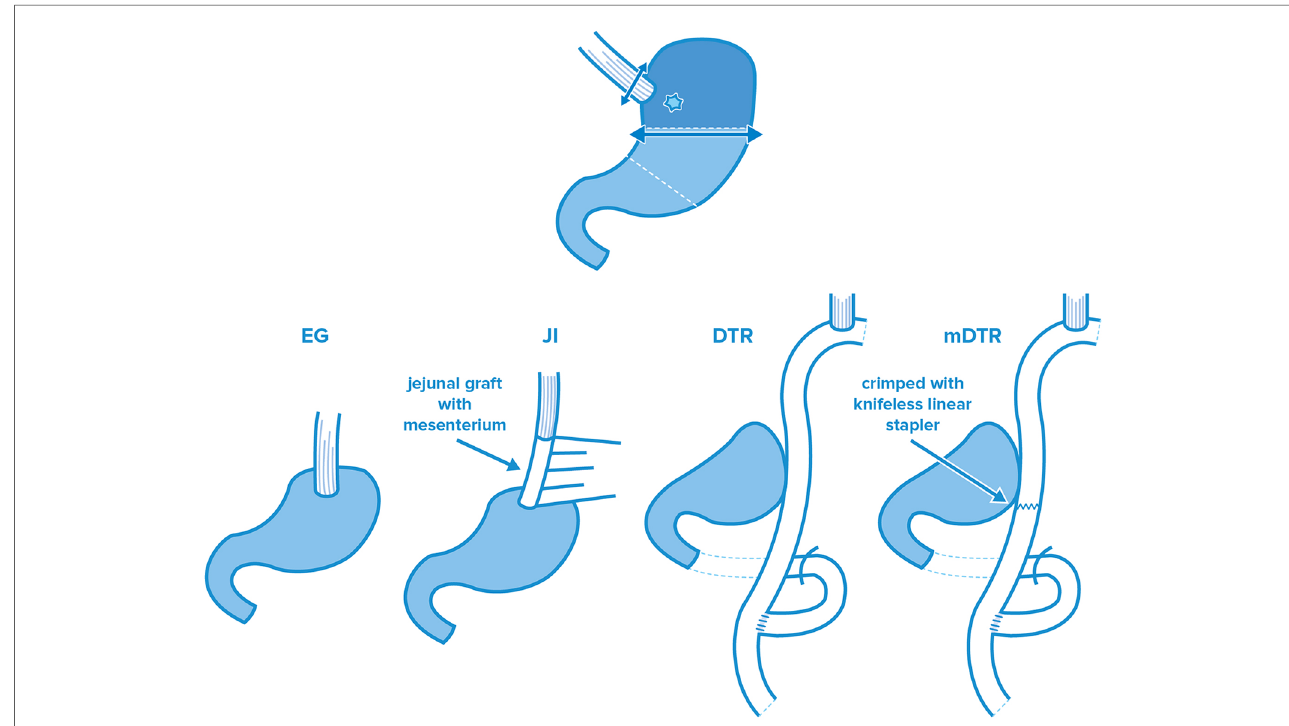
FIGURE 1 Standard reconstruction procedures after PG: esophagogastric anastomosis (EG), jejunal-interposition technique (JI), double — tract (DTR) and modi fi ed double — tract (mDTR)